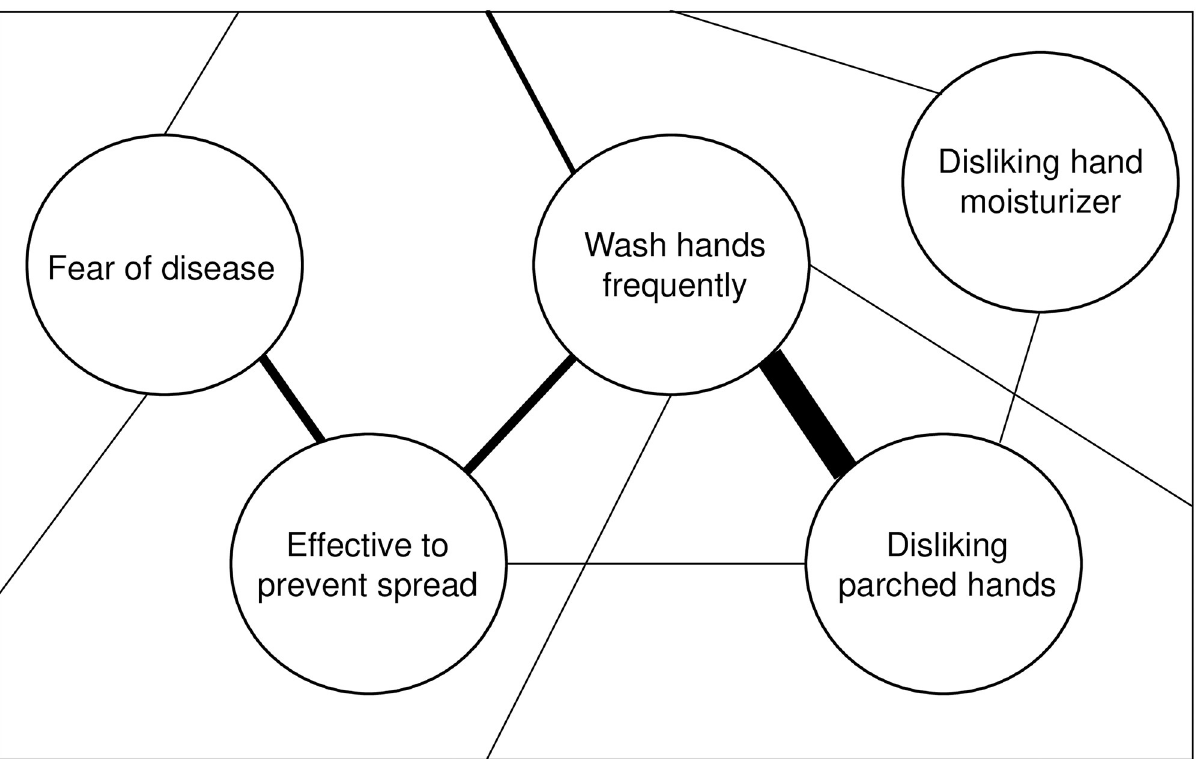
Fig 1. Part of hypothetical and simplified attitude network. The network concerns the attitude towards hand hygiene, consisting of a behavioral element (‘Washing hands frequently’), a cognitive evaluation (‘Hand hygiene is effective to prevent spread’) and three affective evaluations (‘Fear of disease’ and ‘I dislike [parched hands resulting from hand hygiene / hand moisturizer]’). Strength of the relations is indicated by edge width. In this example, disliking parched hands has a stronger relation to washing hands frequently than perceiving hand hygiene as effective to prevent the spread, indicating that the former consideration has a stronger association with the behavioral element than the latter (which is indicated in the network by different edge width). Furthermore, although disliking hand moisturizer is indirectly associated with the behavioral element of washing hands through the disliking parched hands node, this affective evaluation is (in this fictitious case) not directly related to washing